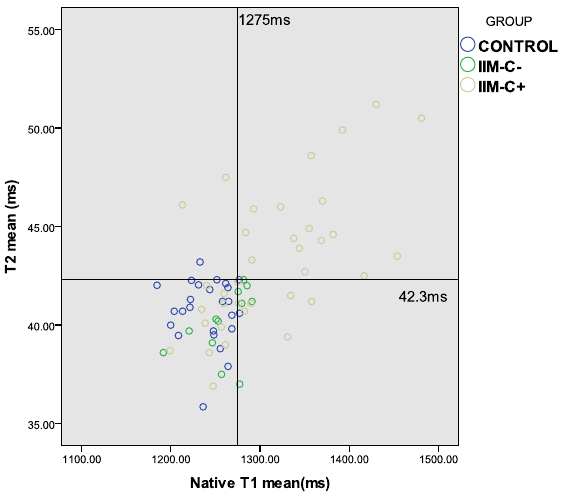
Figure 5. Scatter plots of T1 mean and T2 mean of control and IIM patients. The reference line of native T1 mean is 1275 ms, and the reference line of T2 mean is 42.3 ms.